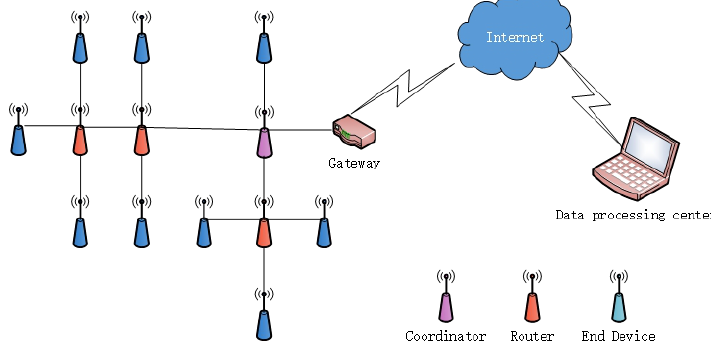
Figure 1. System architecture for pipeline monitoring.